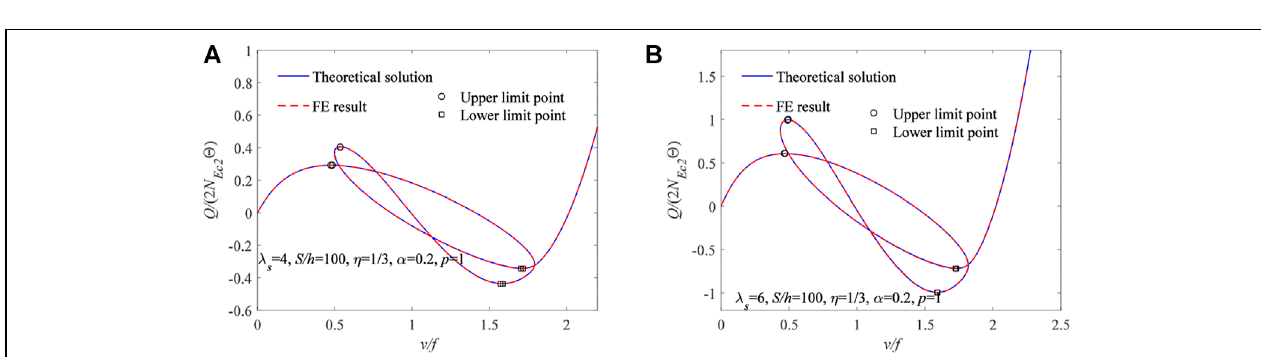
and lower bifurcation instability points, the dimensionless axial The c / Θ − 𝜆 curves of pin-ended FGM arches are shown in force parameter N / 2 N remains constant. When the instability Figure 10 . The instability pattern of the pin-ended FGM arches Ec 2 equilibrium is at a lower bifurcation instability point, the is obviously influenced by the equivalent slenderness 𝜆 and equilibrium path of arches from the bifurcation instability localized parameter c / Θ . In Figure 10 , the instability pattern of equilibrium path is back to the primary equilibrium path. It the pin-ended FGM arches can be divided into four areas: Area was also found that the localized parameter η has an important I is the case of no instability, Area II is the case of limit point influence on the bifurcation instability equilibrium path and the instability, Area III is the case of the lowest bifurcation instability, bifurcation instability load. The local bifurcation instability load and Area IV is the case of dominant bifurcation instability. augments the localized parameter η ; FGM arches bifurcation In addition, Figure 10 shows that the equivalent slenderness instability are more likely to occur when the localized parameters (i.e., 𝜆 , 𝜆 , 𝜆 ) increases with the decrease of the localized sl sb 1 sb 2 η become larger. parameter c / Θ